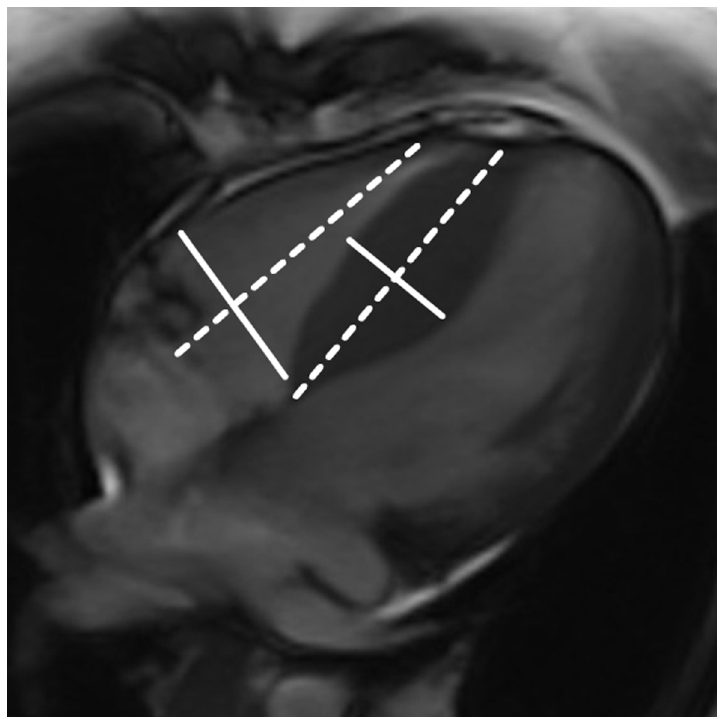
Figure 2. Measurement of the right ventricular and IVS dimensions from 4-CH cardiac views in patients with HCM.